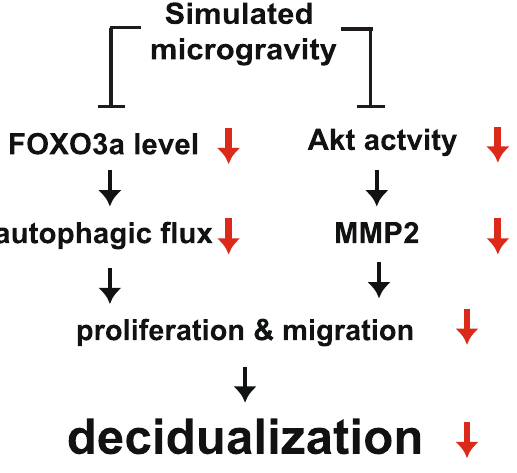
Figure 8. The proposed model of the regulation of decidualization in human eSCs under SM. Exposure of human eSCs to SM decreased FOXO3a expression level and Akt activity, leading to the blockage of